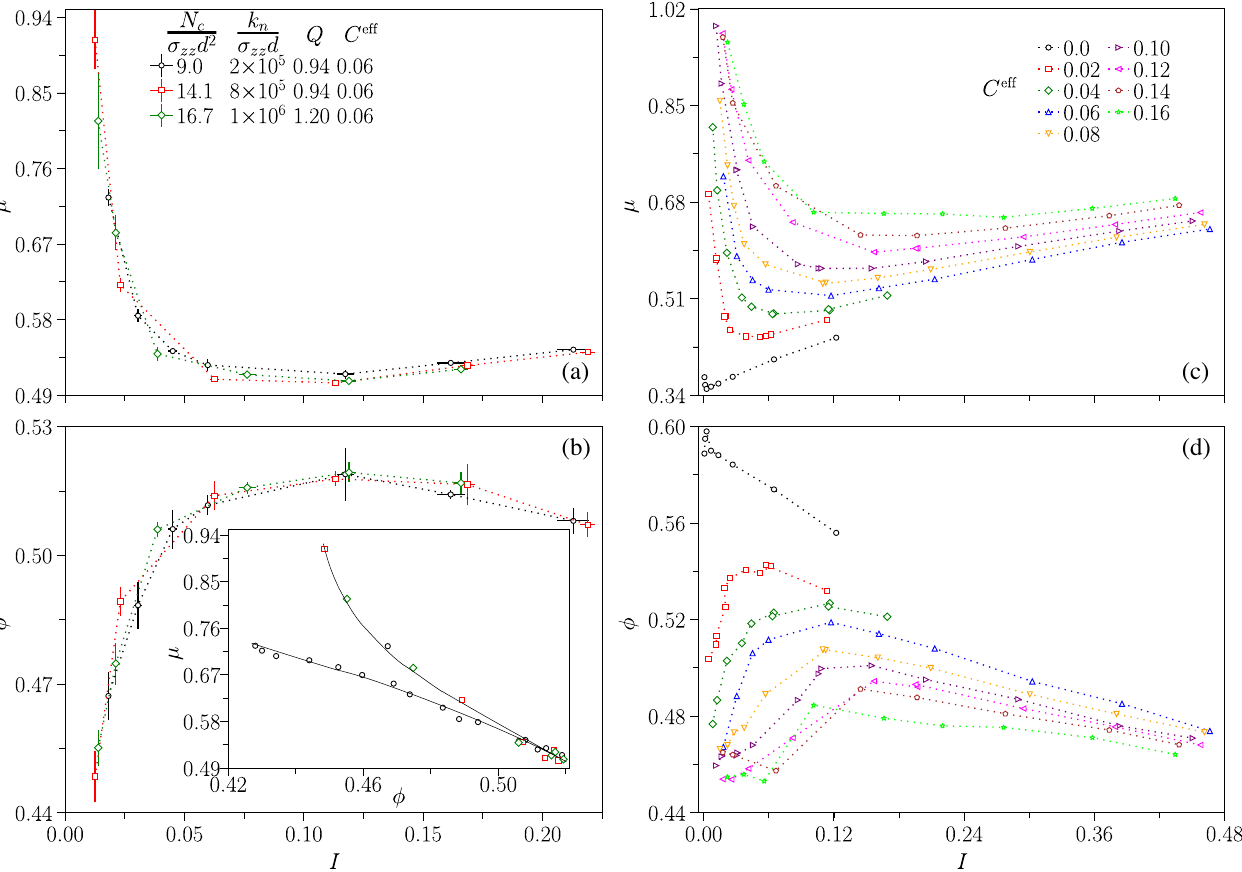
FIG. 5. Nonmonotonic intrinsic rheological curves. (a) The friction coefficient μ and (b) the volume fraction ϕ as a function of the inertial number I for effective cohesion number C eff ¼ 0 . 06 for three different sets of model parameters ð N c ; k n ; Q Þ . Inset: μ as a function of ϕ for the same data as given in (a) and (b), except for the first set of parameters (black circles), for which additional data are included for high I . Solid lines are guides to the eye. (c) μ ð I Þ and (d) ϕ ð I Þ for different values of C eff . Data are obtained for different U during the steady shear rate up sweep using n ¼ 2400 . Error bars in (a) and (b) show the standard deviations over four